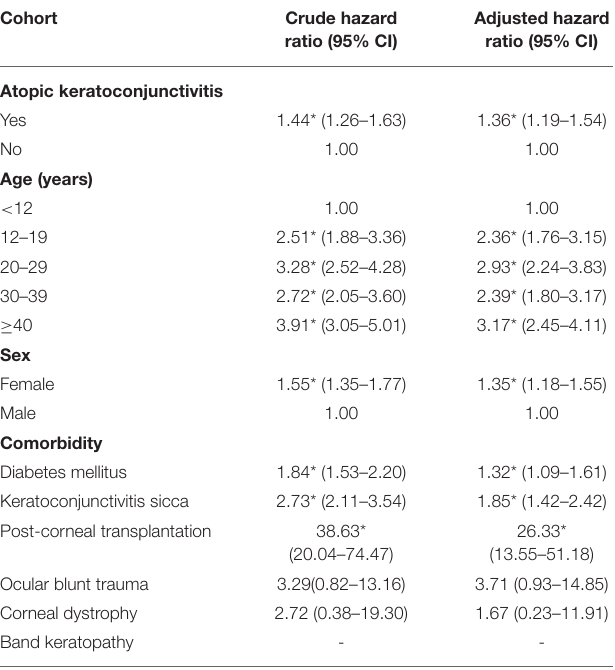
TABLE 3 | Crude and adjusted hazard ratios for the Cox proportional hazard regression analyses and 95% confidence intervals for recurrent corneal erosion in the study cohort during the follow-up period.